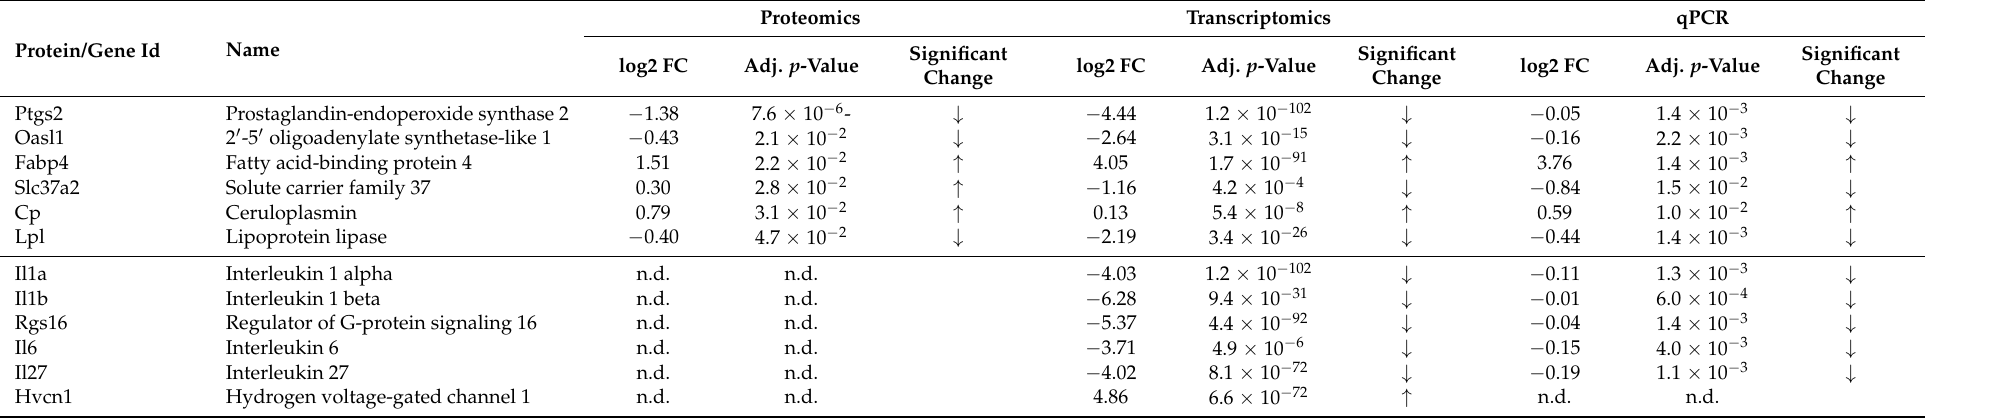
Table 2. Differential abundance for the proteins/genes subjected to validation by qPCR. Fold changes (LPS + I1 vs. LPS) and statistical significance are shown for proteomics, transcriptomics, and qPCR analyses. n.d., no data; ↑ , up-regulated; ↓ ,